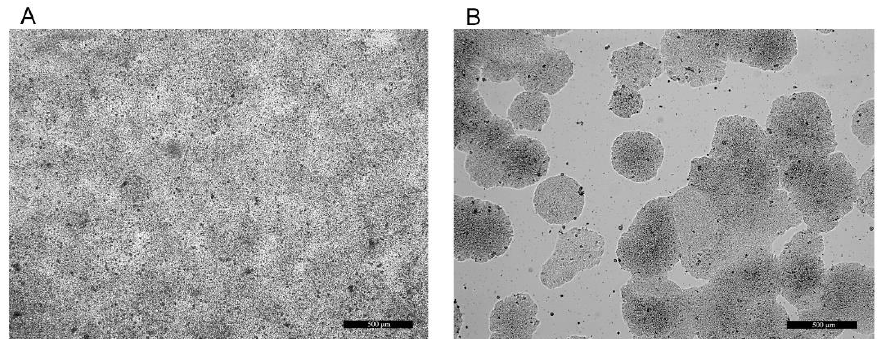
Figure 1. Native micrographs of differentiated (LG, non-proliferating ( A )) and non-differentiated (HG, proliferating ( B )) human colorectal adenocarcinoma HT29 cells. Bars = 500 µ m.